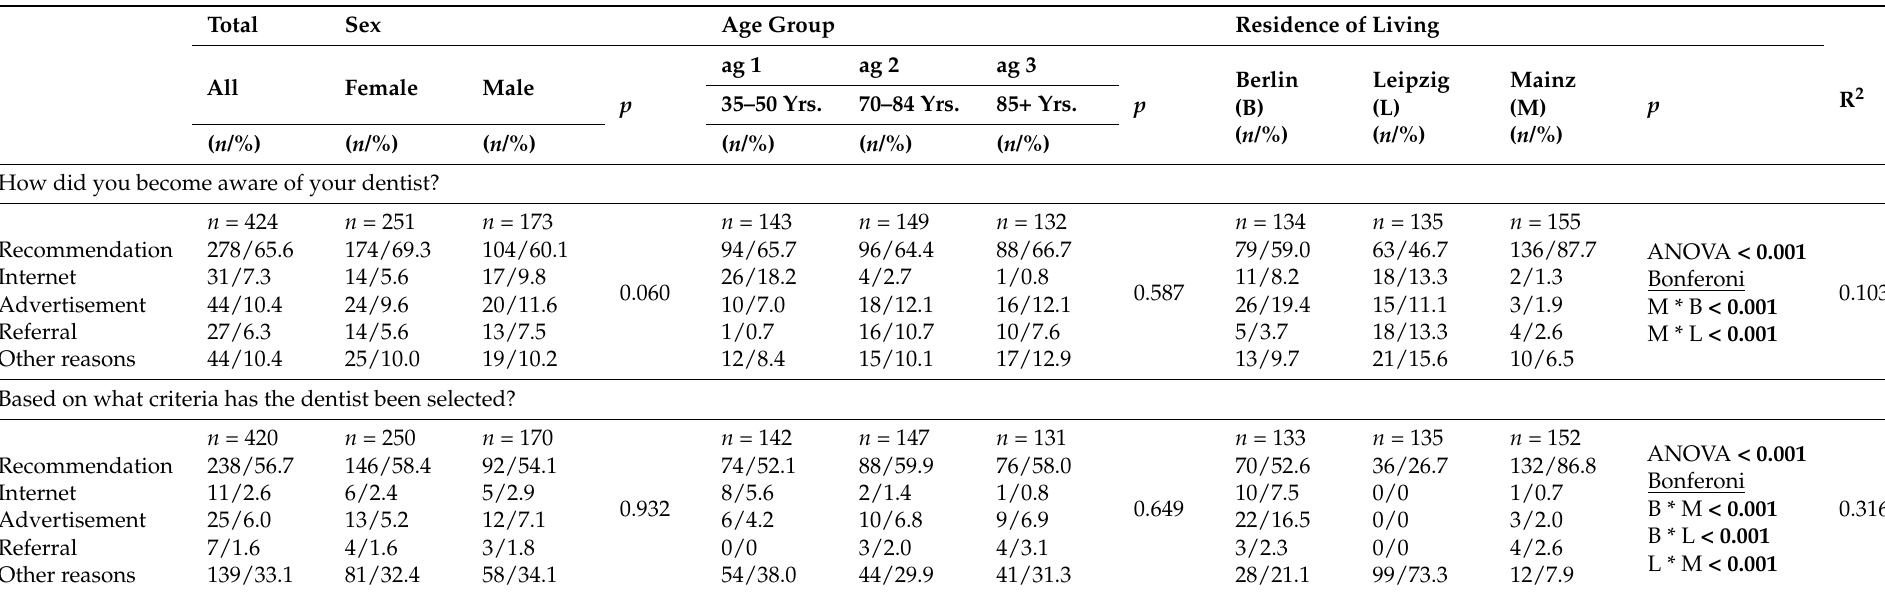
Table 1. Awareness and selection criteria in the choice of dentist presented separately by gender (female n = 279, male n = 187), age group (ag 1 n = 152, ag 2 n = 155, ag 3 n = 159) and place of residence (Berlin n = 152, Leipzig n = 150, Mainz n = 164). (Total (all participants) n = 466; n /%—number/percent, ag—age groups; bold values in column p indicate statistical significance with a significance level of p < 0.05, p = ANOVA with Bonferoni correction for age group and residence of living/without Bonferoni post-hoc test for sex, * indicates the differences between two